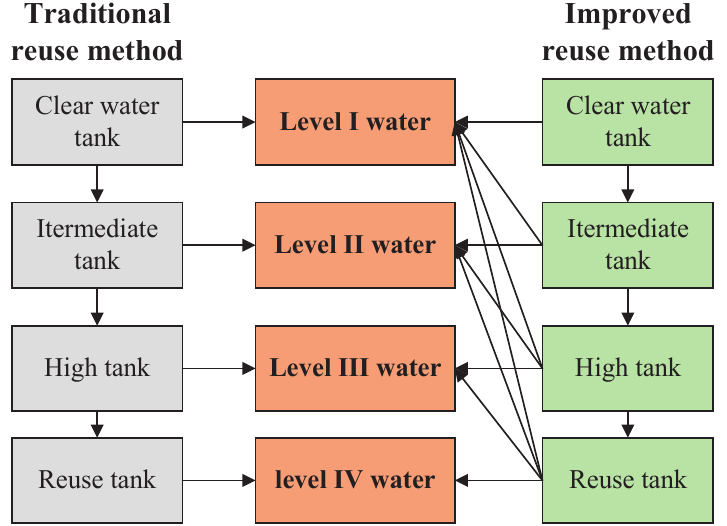
Figure 2. Schematic diagram of multi-level scheduling of mine water reuse